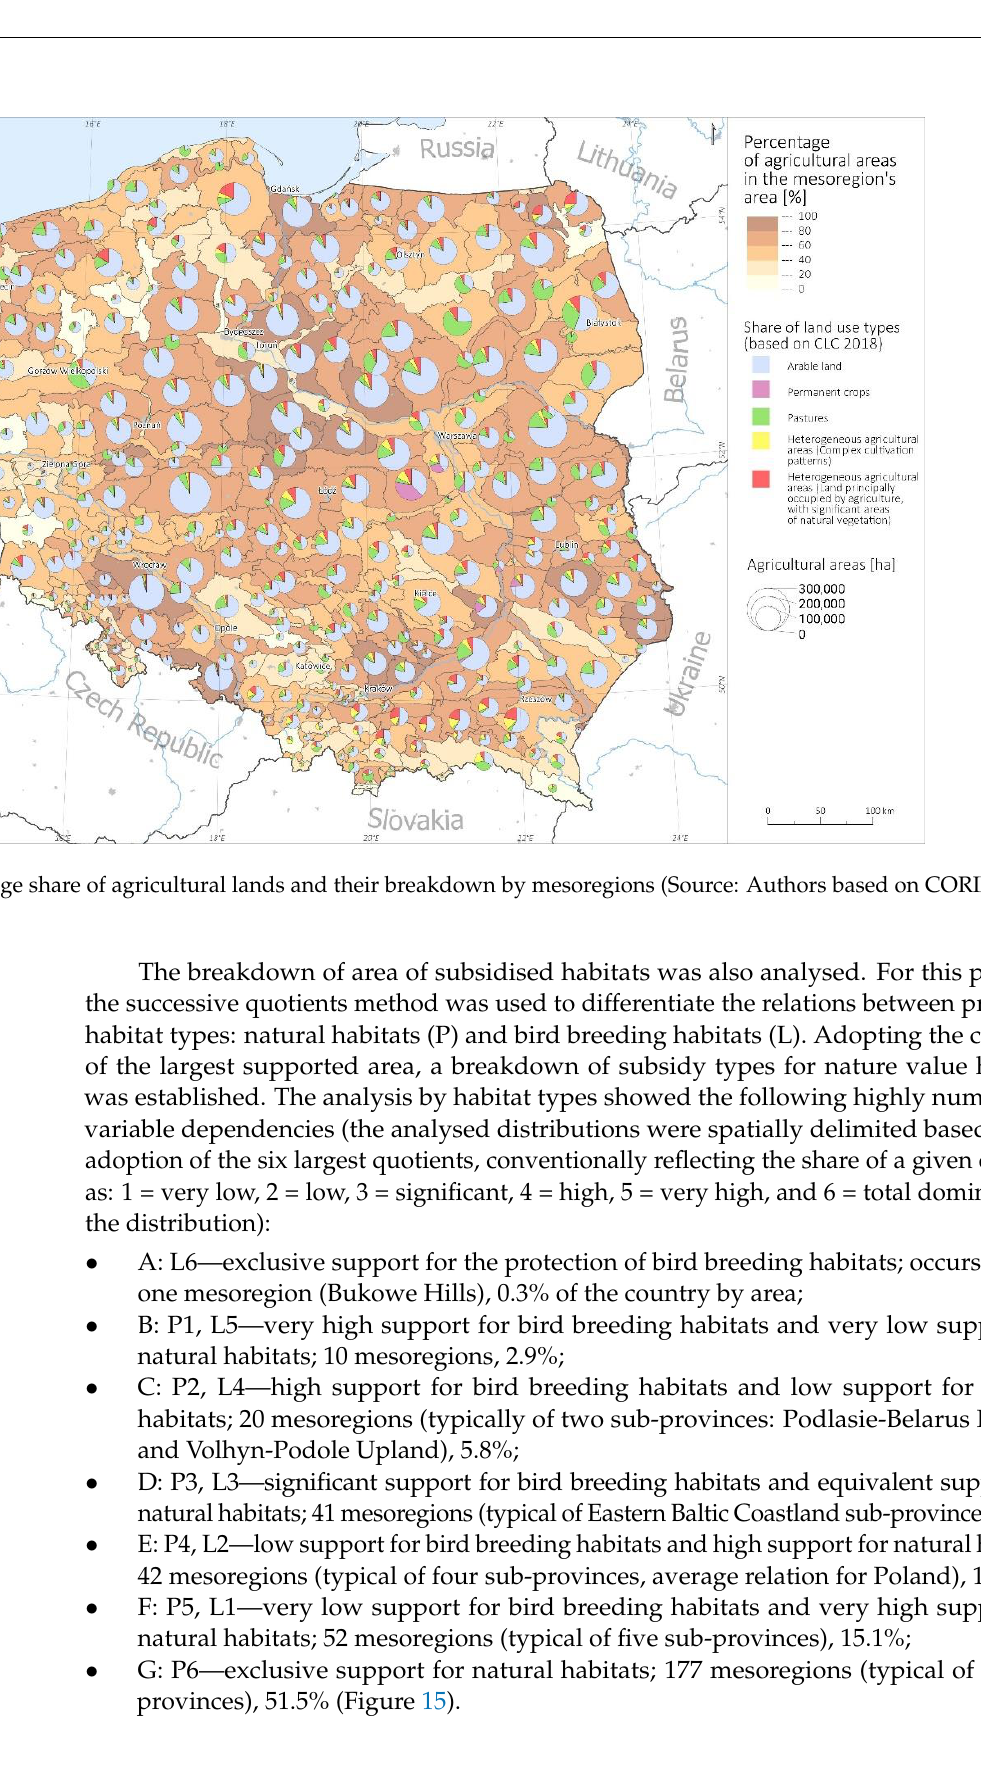
* = number of mesoregions in sub-province shown in brackets; ** = area of part of region located in Poland (Source: Authors based on ARMA data).